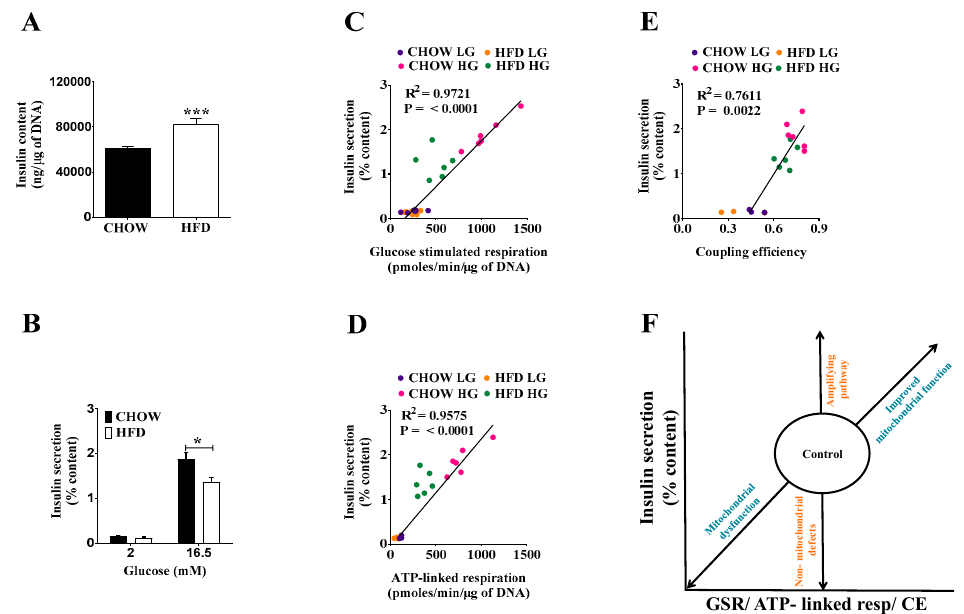
Figure 3. Glucose-stimulated insulin secretion in chow and HFD mice. Batches of eight size-matched islets were exposed to either 2 or 16.5 mM glucose for 1 h at which point supernatants and lysates were collected for ( A ) insulin content, and ( B ) secreted insulin measurements. Correlation between insulin secretion (% content) and ( C ) glucose-stimulated respiration, ( D ) ATP-linked respiration, and ( E ) coupling efficiency ( F ) correlation model classifying defects of insulin secretion. Data are represented as means ± SEM ( n = 6 mice per group, each mouse was considered as independent experiment and islets were plated in triplicate). Statistical significance of mean differences was tested by unpaired two-tailed student t -test. p < 0.05 (*), p < 0.001